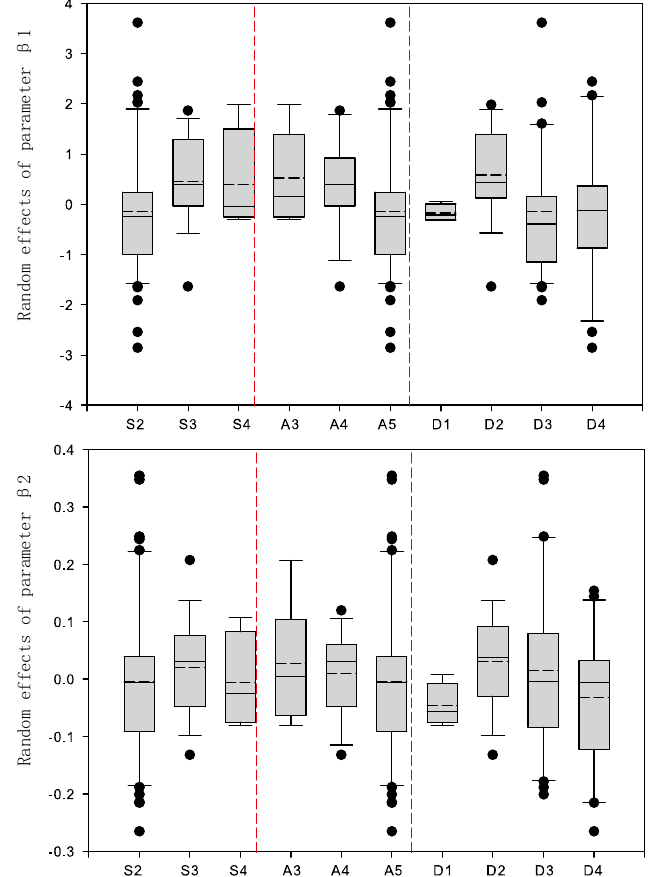
Figure 5. Box-plots of random effec ts for parameters β 1 and β 2 for the third-order branches